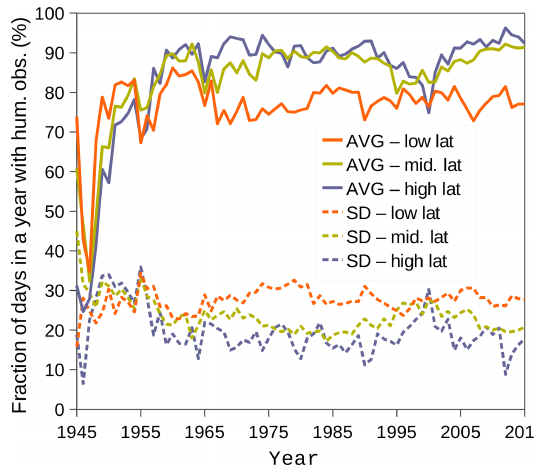
Figure 6. Statistical measures of the fraction of days in a year with humidity observations from 1945 to 2015, representing the fixed radiosonde stations over the major latitude regions for both hemi- spheres: average among stations with humidity data, and standard deviation. Low lat – abs. latitudes < 30 ◦ ; mid. lat – abs. latitudes between 30 and 60 ◦ ; high lat – abs. latitudes > 60 ◦